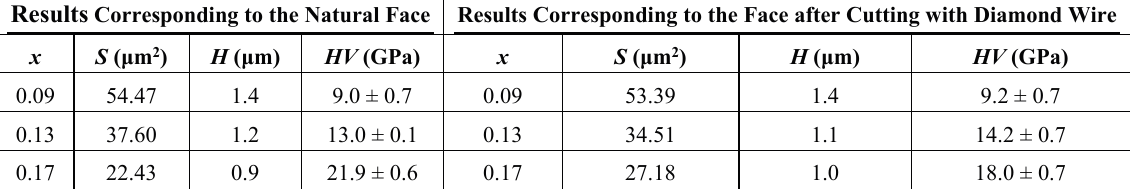
Table 6. Results of microhard ness measurements ( x —nominal Ce concentration in the samples; S —the surface area of the resulting indentation; h —indentation depth; HV —microhardness of the